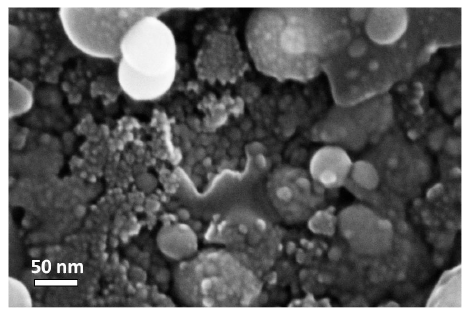
Figure 7. High-magnification FESEM micrograph of films deposited from a target with a Cr-B molar ratio of 1:4 at a substrate temperature of 500 ◦